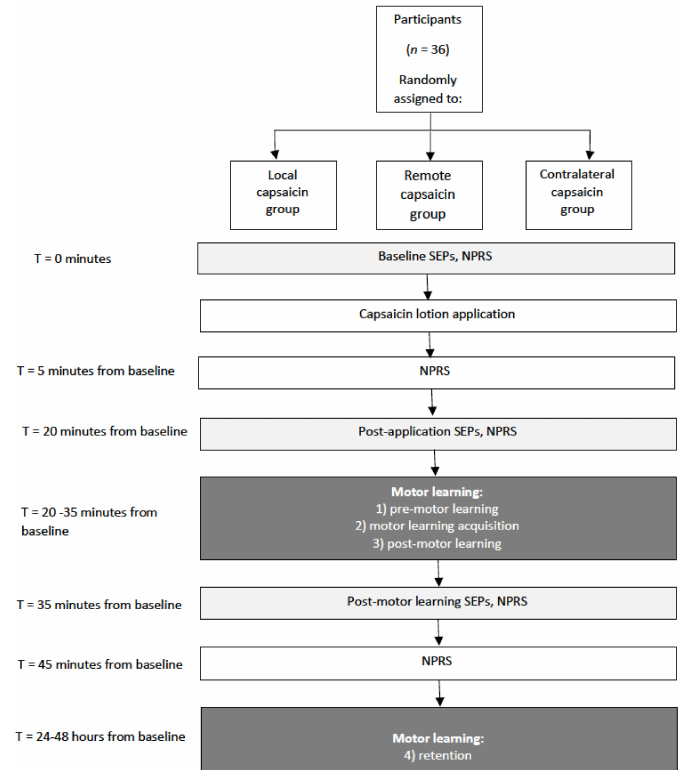
Figure 1. Schematic of the protocol. Somatosensory evoked potentials (SEPs), Numeric pain rating scale